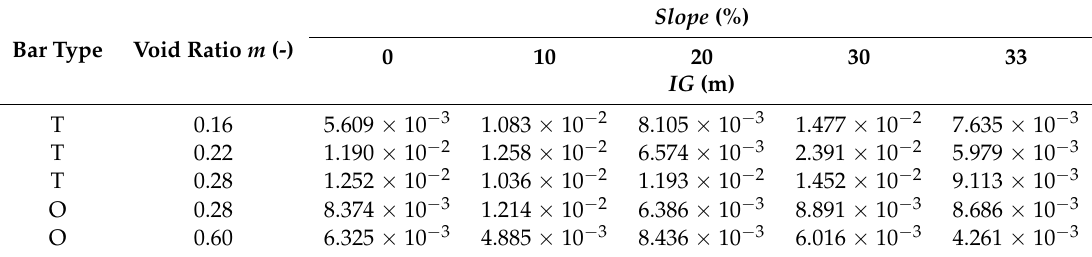
Table 5. Index of goodness of the fit between measured and calculated values .